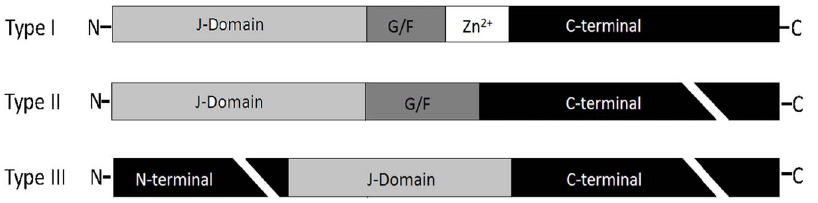
Fig. 1. Schematic presentation of three sub-types of HSP40 family. Type I DnaJ proteins have full domain conservation with Escherichia coli DnaJ, type II DnaJ proteins have a J domain and G/F (Gly/Phe-rich region) motif at N-terminus, type III DnaJ proteins only have a J domain anywhere in the